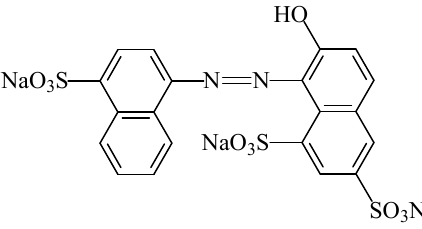
Figure 20. Structural formula of the ponceau 4R colourant (E124).